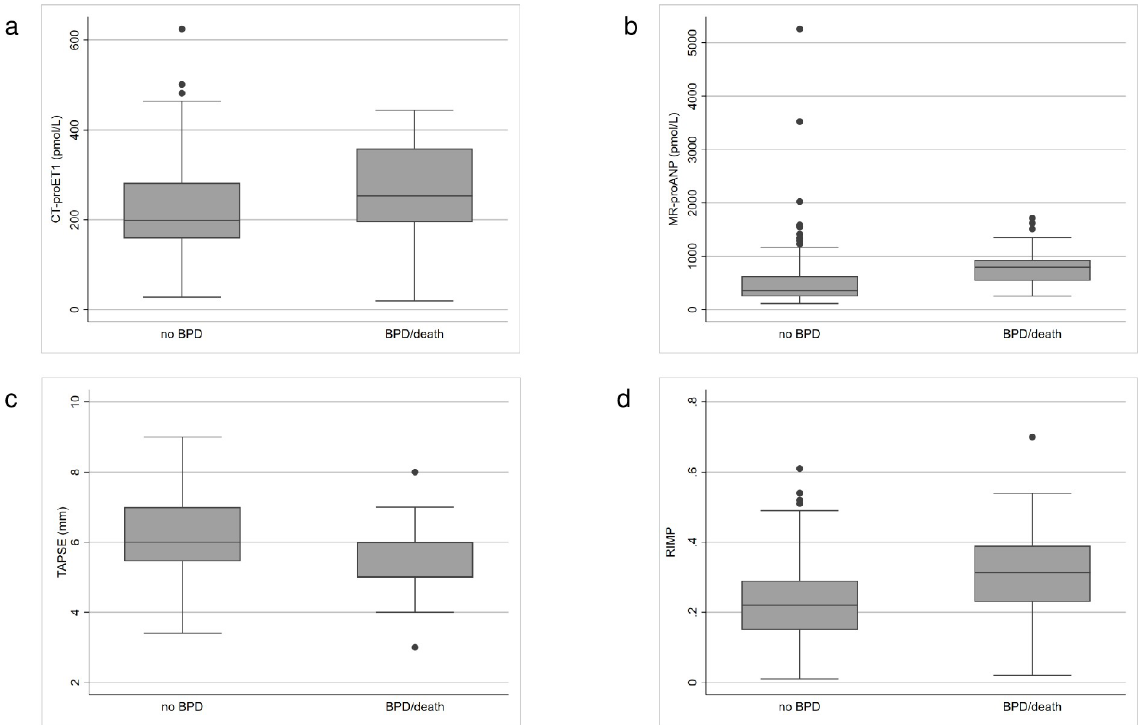
Fig 2. Echocardiographic parameters and vasoactive peptides in infants without BPD and with BPD/death. (a) CT-proET1 levels; (b) MR- proANP levels; (c) tricuspid annular plane systolic excursion (TAPSE); (d) right ventricular index of myocardial performance (RIMP).